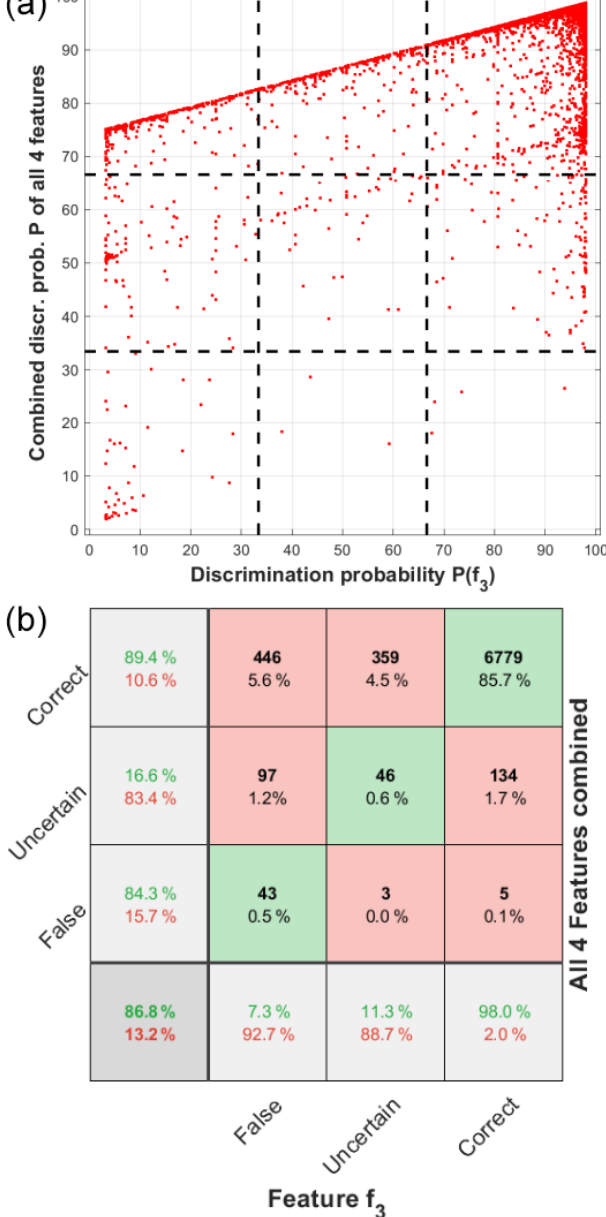
Figure B1. (a) Correlation of the discrimination (classification) probability of feature parameter f 3 alone and the combination of all four features. The dashed lines mark the confidence limits. P(f ) > 66% corresponds to particles that are classified correctly with high confidence; 33 < P(f ) ≤ 66% means the classification is uncertain; and particles with P(f ) ≤ 33% are classified falsely as droplets with high confidence. Panel (b) shows the corresponding statistics of the plot in a confusion matrix. The squares correspond to the dashed lines in (a)